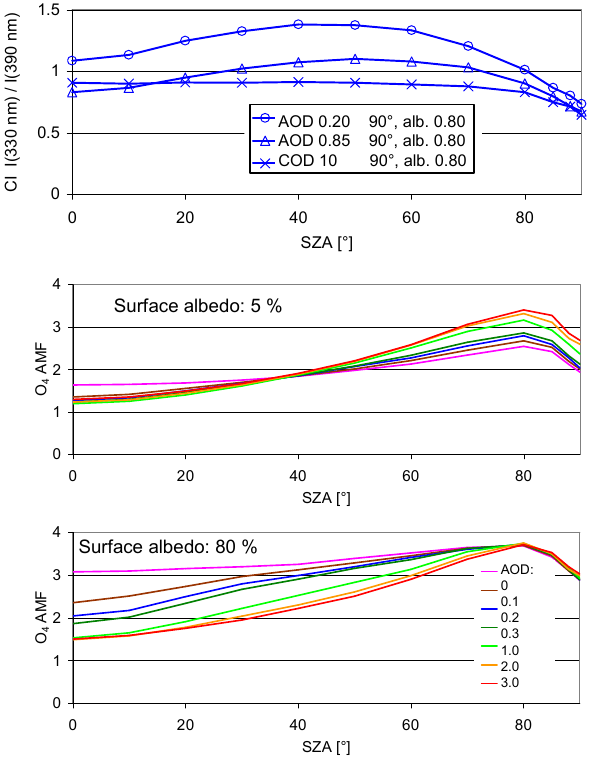
Figure 18. Top: simulated CI for zenith direction for clear-sky mea- surements above bright surfaces (albedo = 80%). Middle and bot- tom: simulated O4 AMF for low (5%) and high (80%) surface albedo. The different colours indicate results for different AOD.